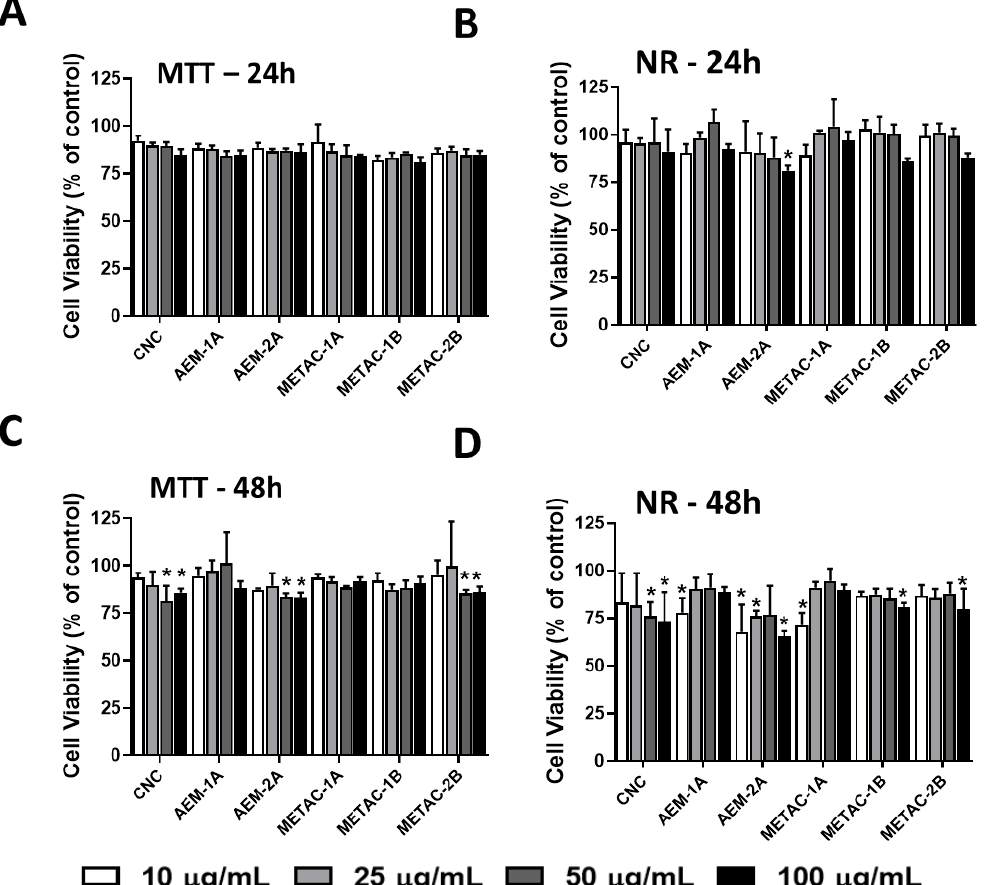
Figure 5. Effect of unmodified and modified CNCs on the cell viability of the HUVEC culture assessed by MTT ( A , C ) and NR ( B , D ) assays. After 24 h ( A , B ) or 48 h ( C , D ) of treatment, cell viability was determined spectrophotometrically using the respective assays. Representative of three independent experiments in triplicates. * p < 0.01 compared to the control, non- treated cells, (100% cell viability, Dunnett’s) .